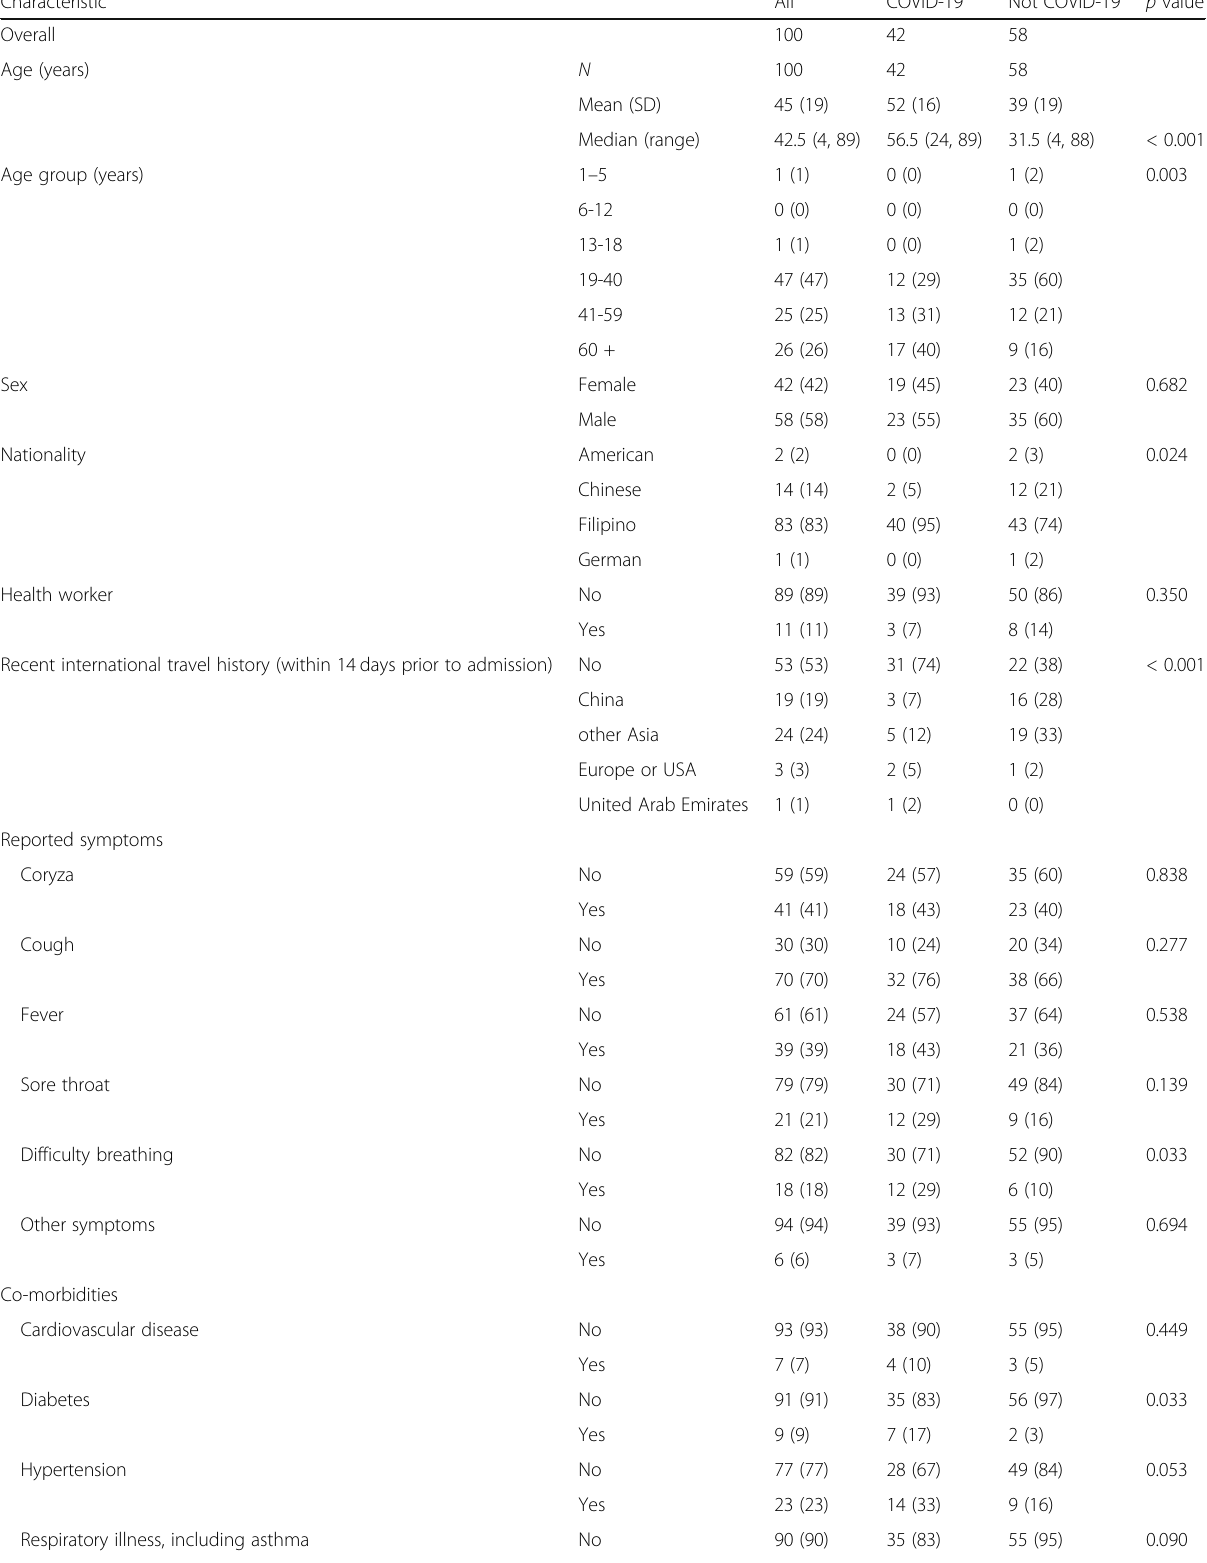
Table 1 Demographic and baseline characteristics of suspected COVID-19 patients